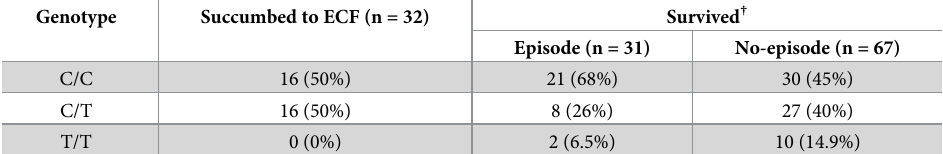
Table 3. IDEAL cohort